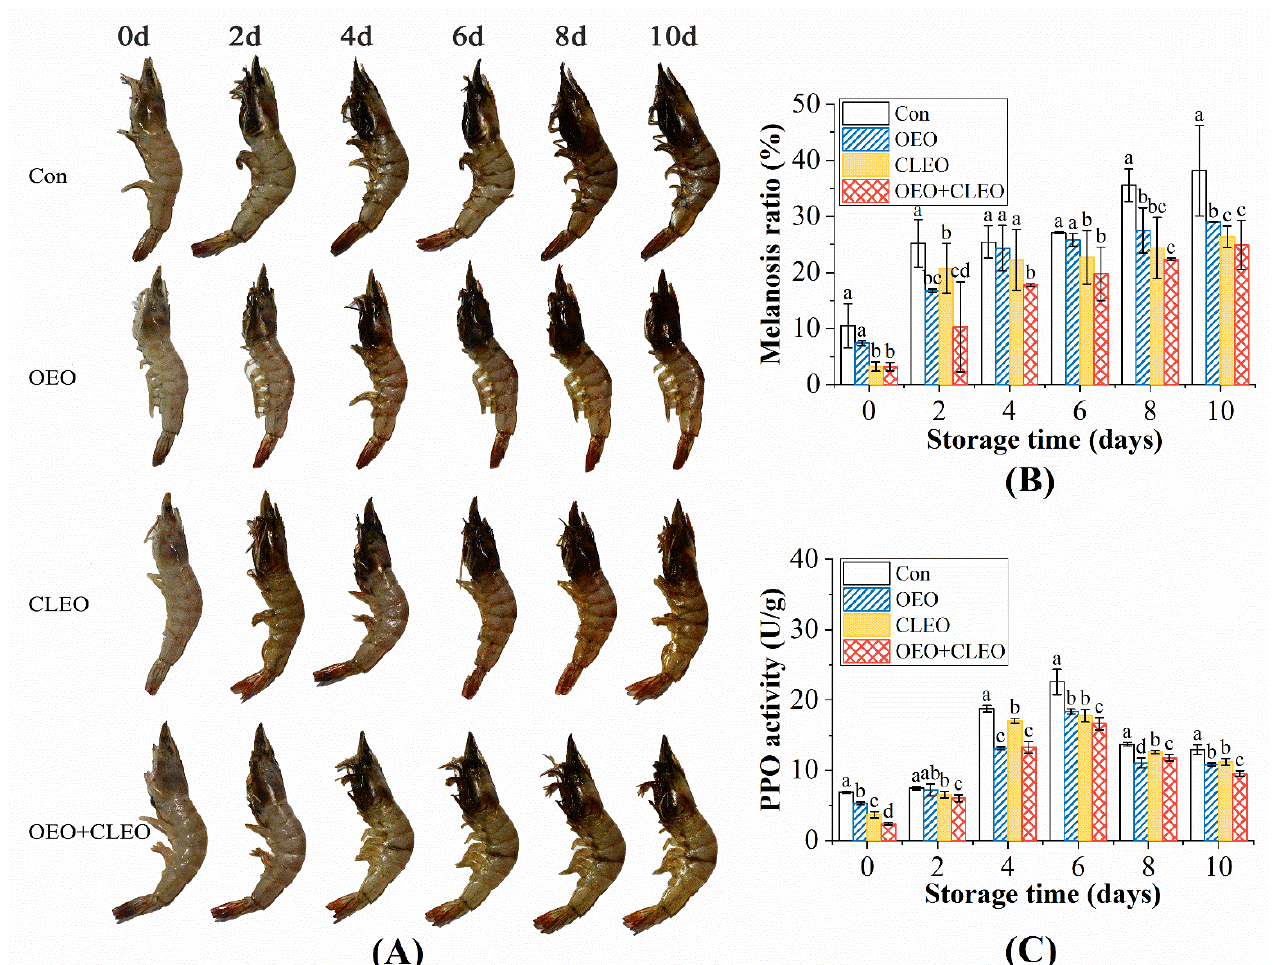
Figure 4. Photograph ( A ) and changes of melanosis ratio ( B ) and PPO activity ( C ) of refrigerated Pacific white shrimp treated by OEO and CLEO at 4 °C. Data are shown as mean ± SD (n = 3). Note: Different lowercase letters indicate significant differences ( p < 0.05) among different treatments within the same storage time.